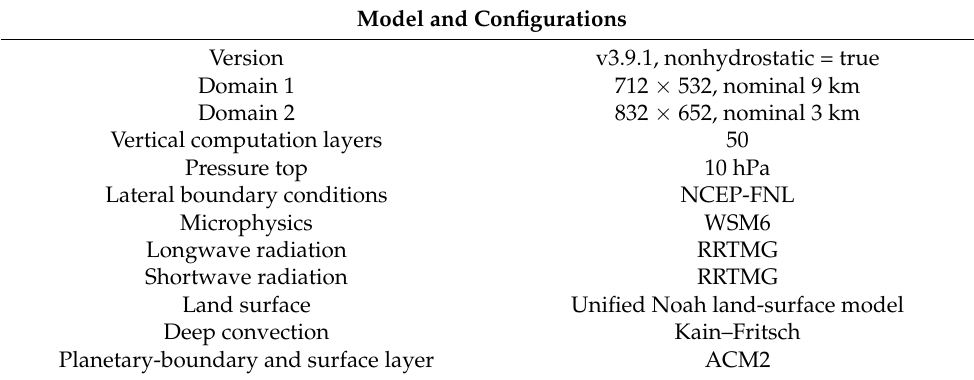
Table 1. Experimental configurations of the WRF model.